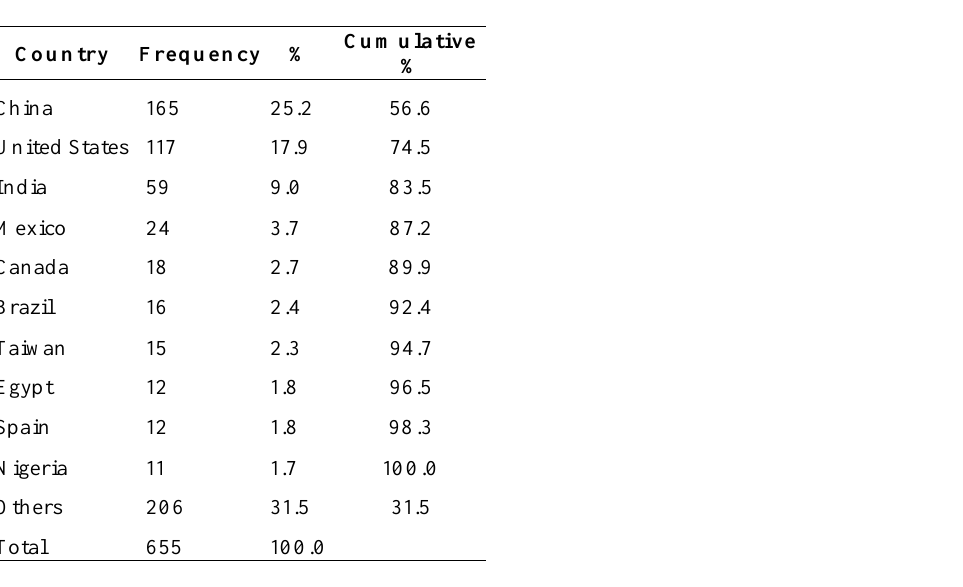
Distribution of Participants by